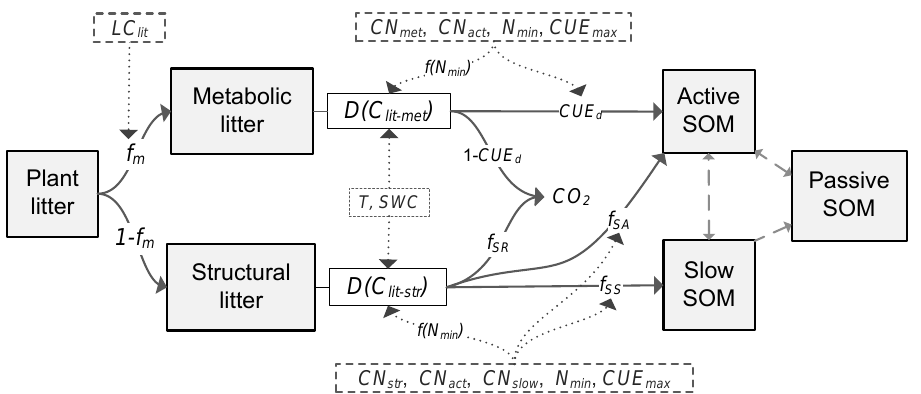
Figure 1. Schematic diagram of the C flows in the litter decay model used in this study. f m is the fraction of metabolic compounds in plant litter. D(C lit-met ) and D(C lit-str ) are the decomposition rates (gCkg − 1 day − 1 ) of metabolic or structural litter, respectively. LC lit is the lignin-to-C ratio (on a mass basis) of plant litter; CN met , CN str , CN act and CN slow are the C:N ratio of metabolic litter pool, structural litter pool, active SOM pool and slow SOM pool, respectively; N min is the concentration of mineral N in solution (gNkg − 1 soil); f ( N min ) is a factor reducing litter decay rate when soil mineral N availability is limiting; T ( ◦ C) and SWC (%) are temperature and soil water content, respectively; CUE d is C use efficiency of the transformation from litter to soil organic matter (SOM); CUE max = 0 . 8 is the maximum microbial CUE (dimensionless) when growth is limited by C from the organic substrate; f SA , f SS and f SR are the fractions of decomposed structural litter C that is transferred to active SOM pool, slow SOM pool and released to atmosphere in forms of CO 2 , respectively. As in the algorithms in the CENTURY model (Parton et al., 1988), here f SA = CUE d_SA × ( 1 − f lig ) , f SS = CUE d_SS × f lig , f SR = 1 − (f SA + f SS ) , where f lig is the lignin fraction (0–1, dimensionless) in the structural litter pool, and CUE d_SA and CUE d_SS are the CUE of C transformation from structural litter pool to active and slow SOM pools,